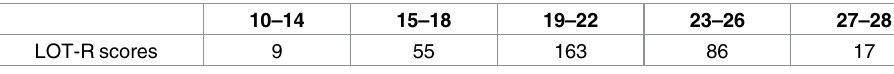
Table 2. Distribution of LOT-R scale scores of the